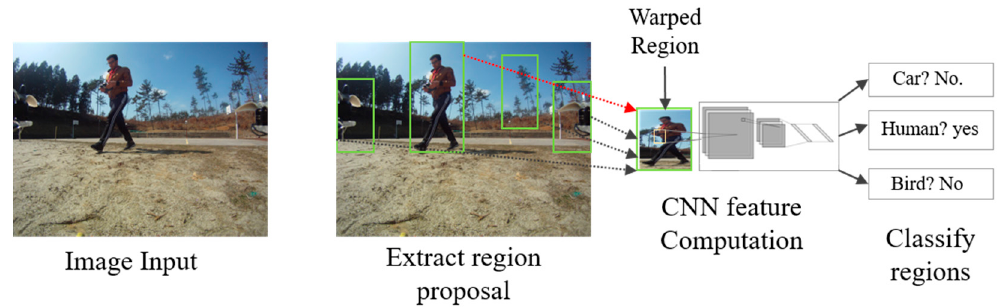
Figure 12. After creating a set of region proposals, R-CNN uses a modified version of AlexNet to determine the valid region.